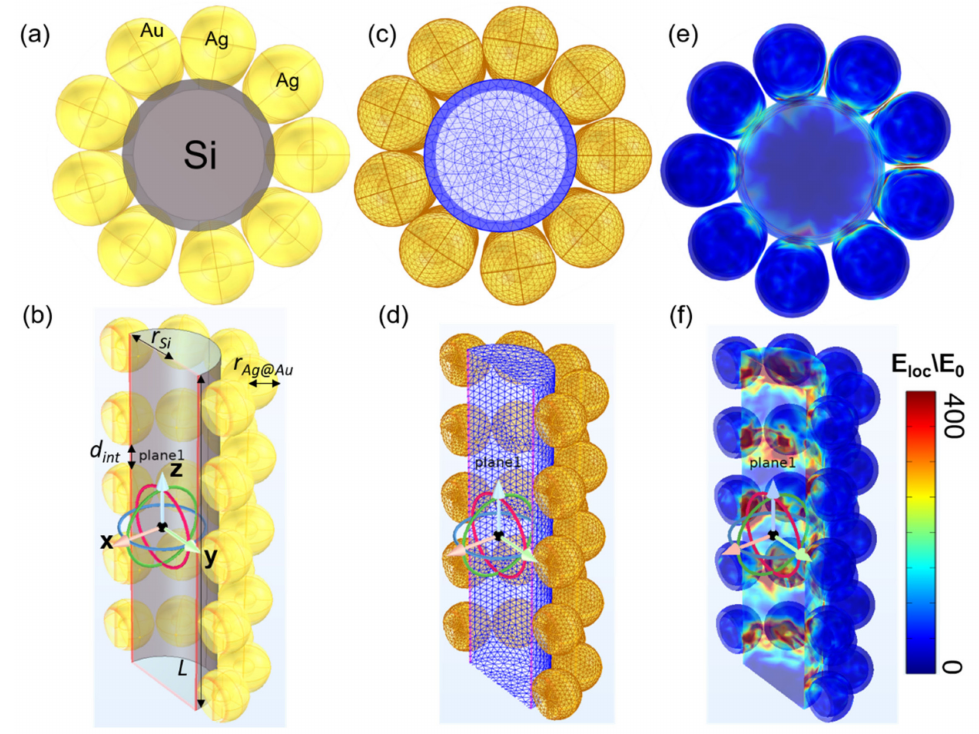
Figure 6. ( a ) 3D configuration model of Si nanonatenna surrounded with Ag/Au cores-shell nanosphere. ( b ) Dimension of the cross section in the xz plane: Si nanoantenna radius r Si = 10